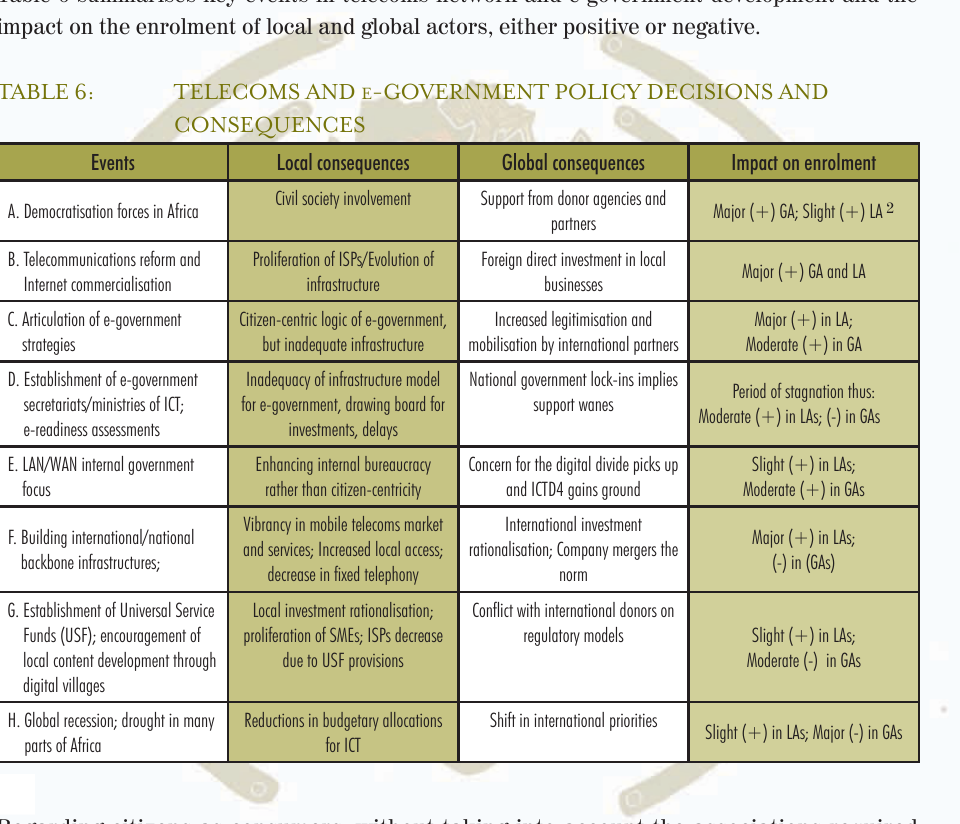
TELECOMS AND E -GOVERNMENT POLICY DECISIONS